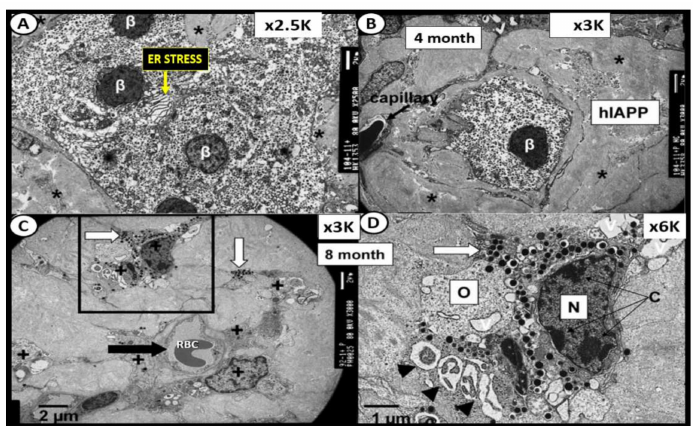
Figure 10. The 4- and 8-month-old HIP rat. (Panels ( A , B )) from the 4-month-old HIP rat models. Panel ( A ) illustrates endoplasmic reticulum (ER) stress with prominent widening of the ER in β -cells (yellow arrow) and also note the islet amyloid (asterisk) in left lower region. Panel ( B ) depicts a single β -cell embedded and totally isolated by islet amyloid / human islet amyloid polypeptide (hIAPP) amyloidosis in 4-month-old HIP rat models. Panels C and D are from the 8-month-old HIP rat model. (Panel ( C )) displays the marked decrease in β -cells, which are atrophic and represent changes of apoptosis. Note the islet capillary with its red blood cell (RBC) and its close association with an atrophic apoptotic β -cell with apoptotic bodies and loss of insulin secretory granules (black arrow). (Panel ( D )) depicts an apoptotic β -cell from boxed in area in panel ( C ) and note the apoptotic bodies (arrowheads), loss of cytoplasmic organelles (O) and cytoplasmic vacuoles (apoptotic bodies) along with its nucleus (N) depicting chromatin condensation (C). β = β -cell; K = 1000; N = nucleus; O = cytoplasmic organelle; RBC = red blood cell.